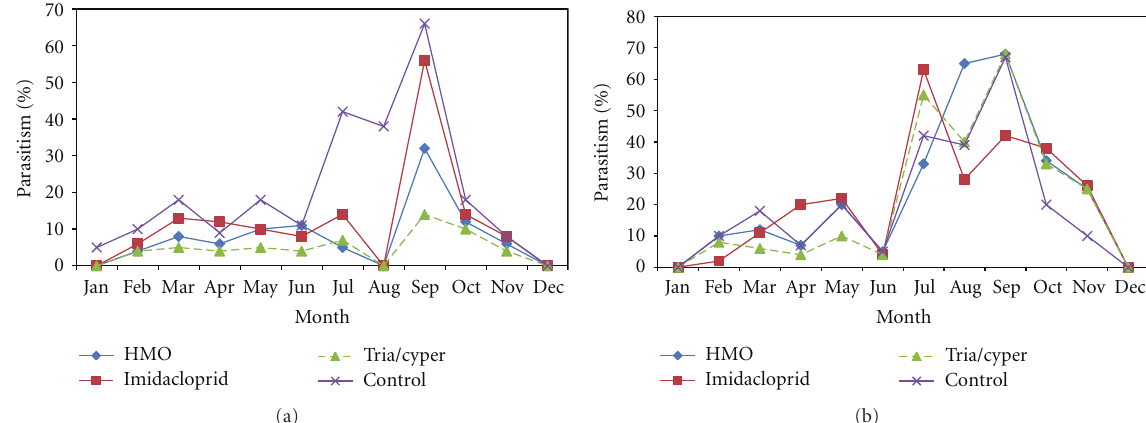
Figure 4: (a) E ff ect of treatments on percentage of parasitism on D. citri nymphs by T. radiata in a citrus orchard. (b) E ff ect of treatments on percentage of parasitism on D. citri nymphs by D. aligarhensis in a citrus orchard.